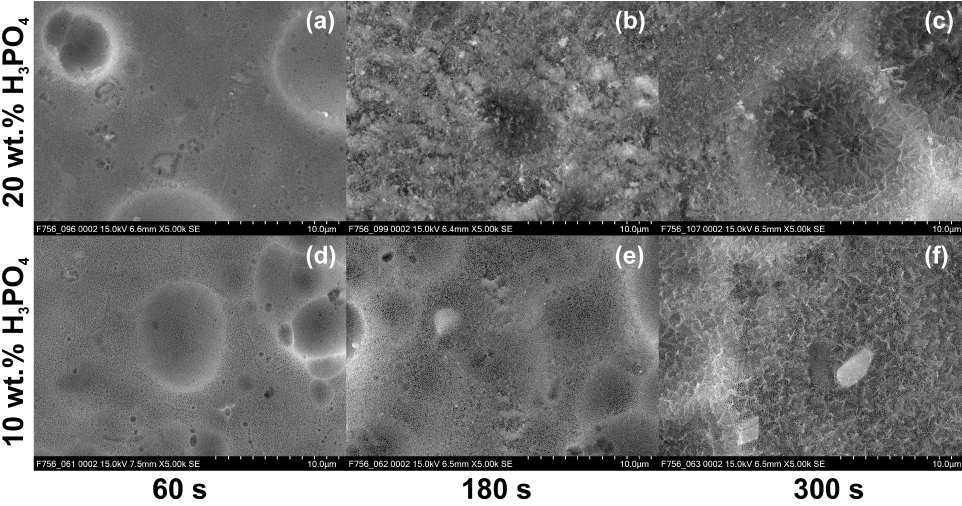
Figure 4. SEM micrographs of anodized surfaces obtained at different acid concentrations. ( a – c ) 10 wt.-%; ( d – f ) 20 wt.-% (bath temperature 40 °C, voltage 50